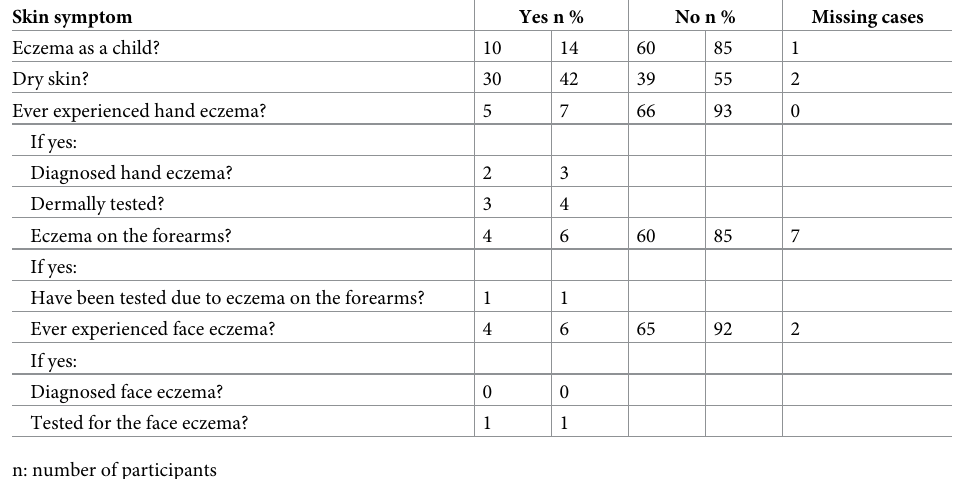
Table 5. Prevalence of skin symptoms among hard metal workers and referents, percentage of answers. Skin symptom